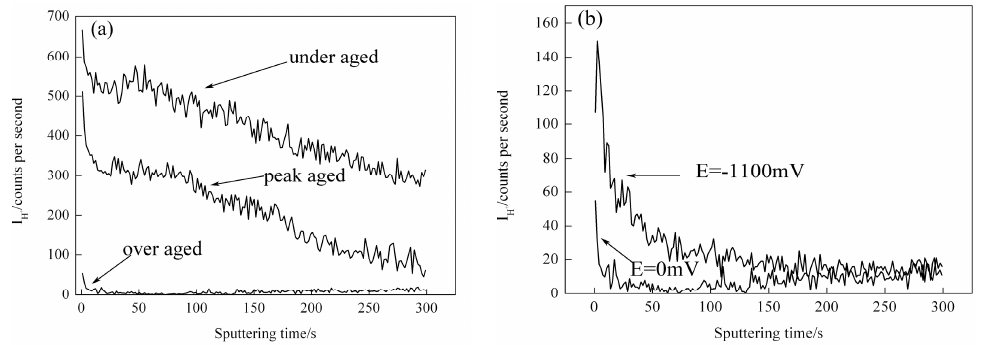
Figure 8. ToF-SIMS sputtering profiles for H + near the crack tip. ( a ) Different aging states; ( b ) over aged state and E = − 1100 mV.